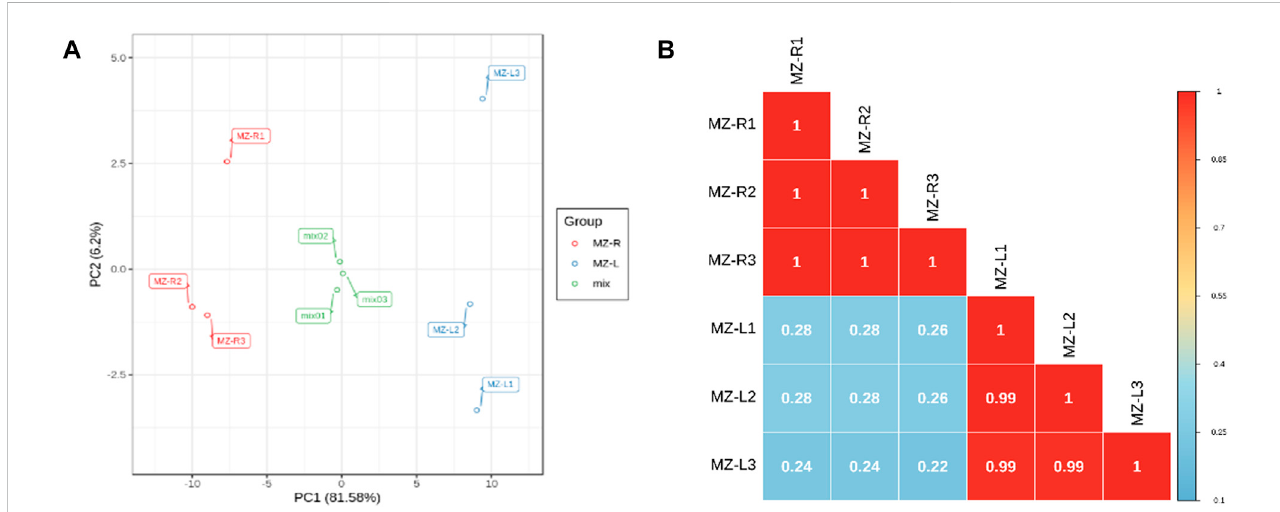
FIGURE 6 Quality control of metabolite compounds in the leaf and root tissues of V. mengtzeanum . (A) Principal component analysis revealing the leaf and root samples replicates grouping and their complete distinction from each other (B) Pearson ’ s correlation coef fi cients (PCC) of metabolites; each sample in triplicates and quality control mix for metabolomics. The color gradient (blue to red) bar on the right represents the correlation between the leaf and root samples of V. mengtzeanum